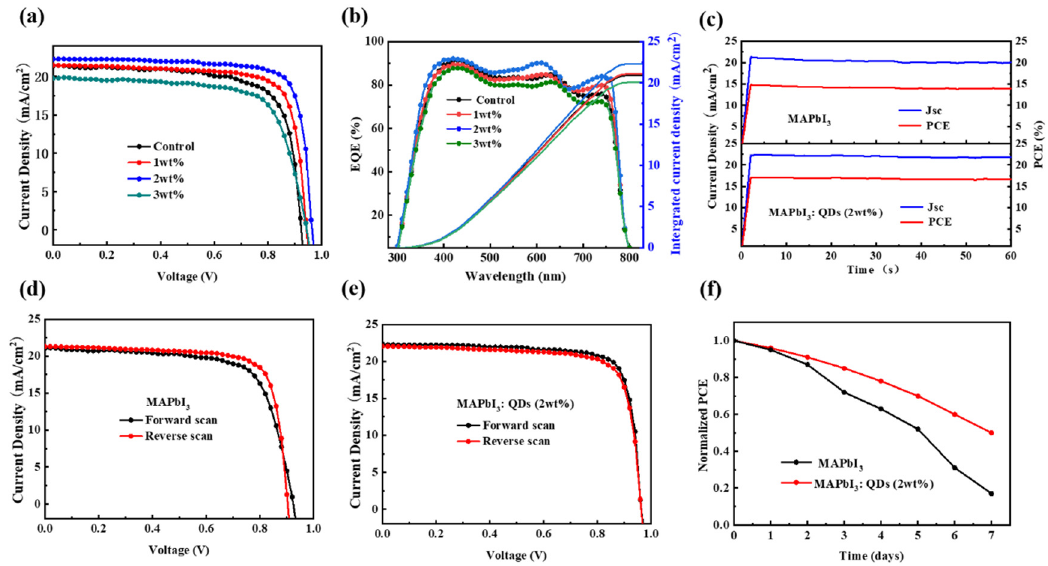
Figure 7. ( a ) J-V characteristics of PSCs; ( b ) EQE and corresponding integrated J SC of PSCs; ( c ) The steady-state power output of PSCs; ( d ) J-V curve hysteresis of the control device; ( e ) J-V curve hysteresis of the optimized device; ( f ) Long time stability of PSCs.